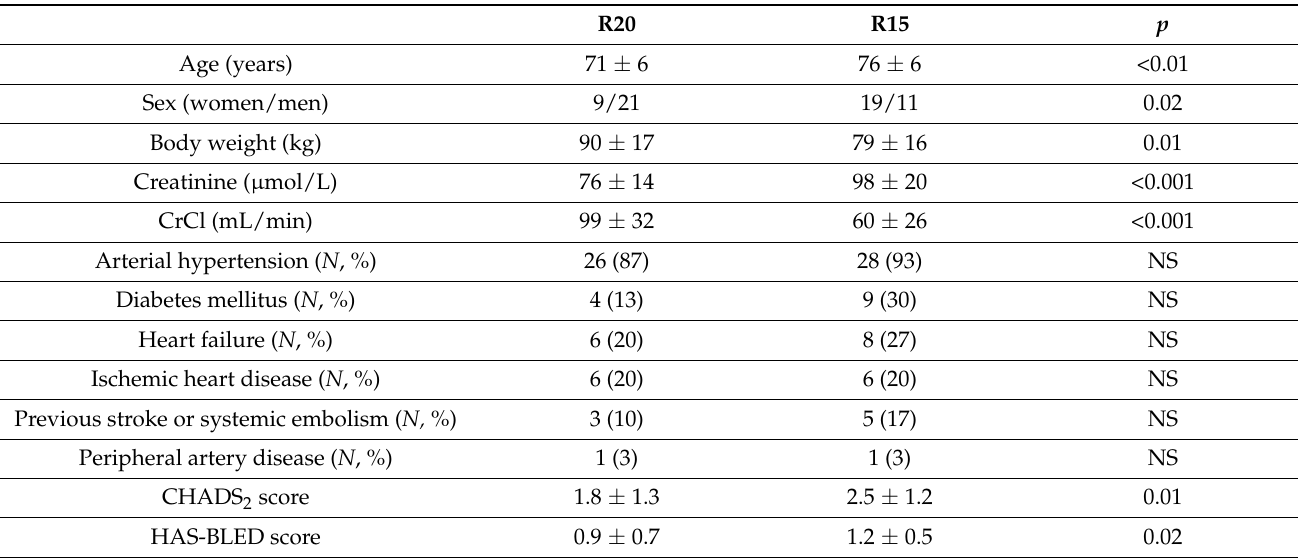
Table 1. Characteristics of the patients on rivaroxaban 20 mg (R20) or 15 mg (R15) daily. Average ± SD or number of cases is given with the